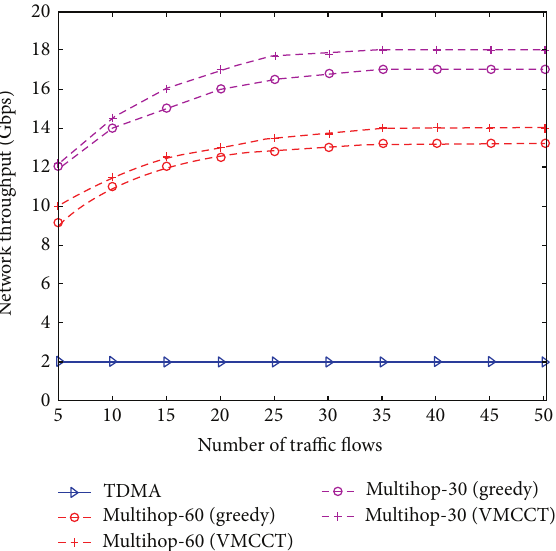
Figure 16: Network throughput in multihop